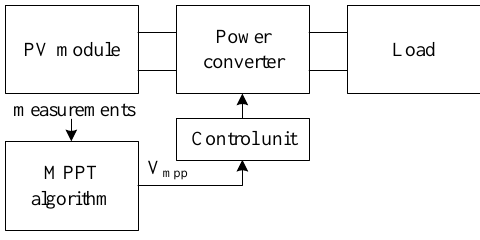
Figure 4. Schematic arrangement for the PV